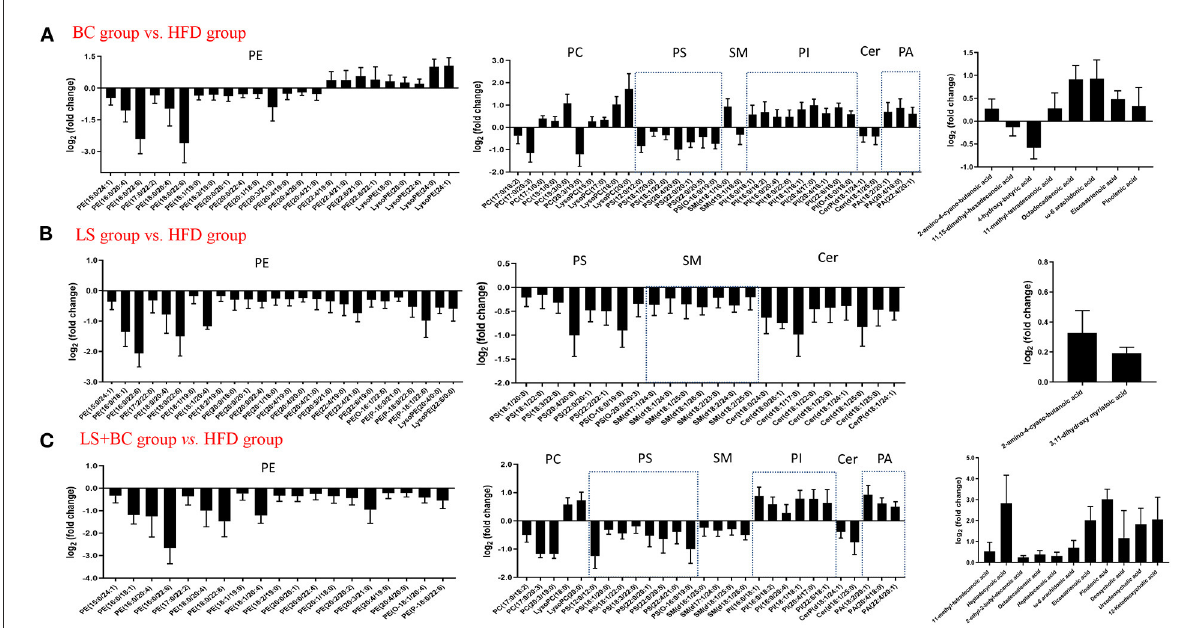
FIGURE6 Subspecies level analysis of the potential lipid biomarkers responsible for anti-obesity and improving lipid profiling after CBPs treatment. (A) BC group vs. HFD group, (B) LS group vs. HFD group, (C) LS + BC group vs. HFD group. PE, phosphatidylethanolamines; PC, phosphatidylcholines; PS, phosphatidylserine; SM, sphingomyelin; PI, phosphatidylinositol; Cer, ceramides; PA, phosphatidic acids.